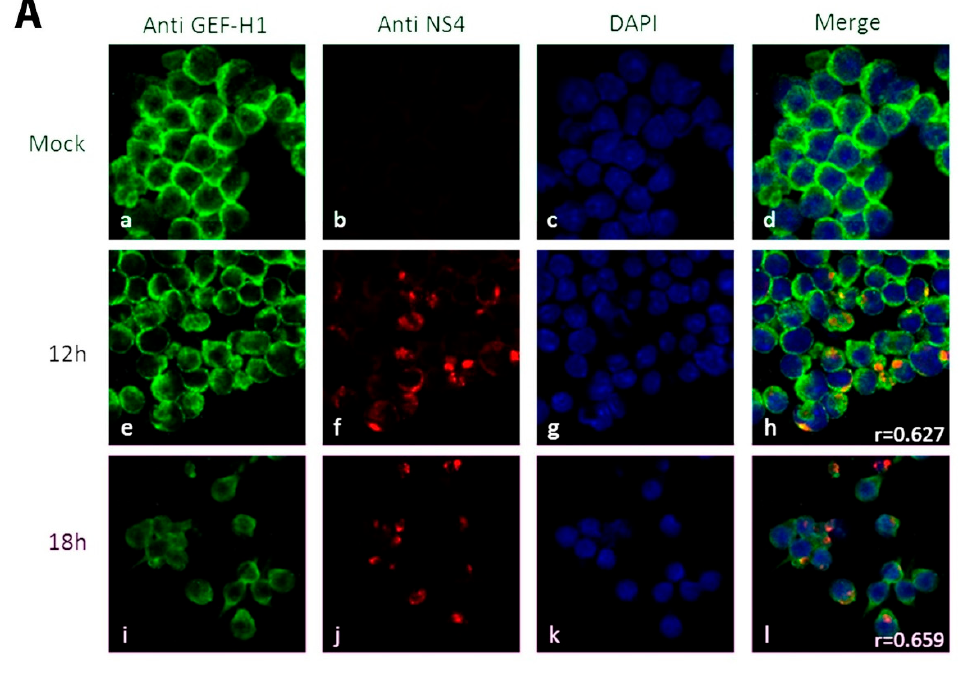
Figure 1. The replication complex (RC) of murine norovirus (MNV) co-localises with the endogenous guanine nucleotide exchange factor-H1 (GEF-H1) in the perinuclear area. ( A ) RAW264.7 cells were infected with MNV (multiplicity of infection (MOI) 5) and fixed at 12 h and 18 h after infection. Panels a, e, and i show the staining for the anti-GEF-H1 antibody (green); panels b, f, and j display the staining with an anti-non-structural protein 4 (NS4) antibody (red); panel c, g, and k represent the nuclear staining with DAPI (blue); and panels d, h, and l show the merged pictured of all channels. Stained cells were analysed via confocal microscopy and the co-localisation was quantified with the Pearson’s coefficient. ( B ) Quantitation of the Pearson’s coefficients. MNV 12 h = 0.57 ± 0.08 ( n = 16) and MNV 18 h = 0.50 ± 0.16 ( n = 14). Bars represent average ± standard error of the mean (SEM). Images were collected over triplicate experiments and analysed in GraphPad Prism (www.graphpad.com/scientific-software/prism/). These results suggest that GEF-H1 might be recruited or sequestered within the MNV RC. This redistribution could be attributed to either (i) a requirement for MNV replication, (ii) a host response involved in the sensing of MNV and the activation of the antiviral immune response, or (iii) targeting by the virus to avoid immune detection and to dampen the anti-viral response. 3.2. Expression of GEF-H1 Leads to Changes in the Localisation of the RC during MNV Infection